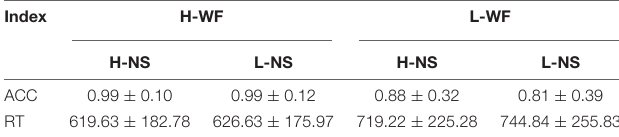
TABLE 2 | Accuracy rate and reaction times (mean ± standard deviation) in four conditions.